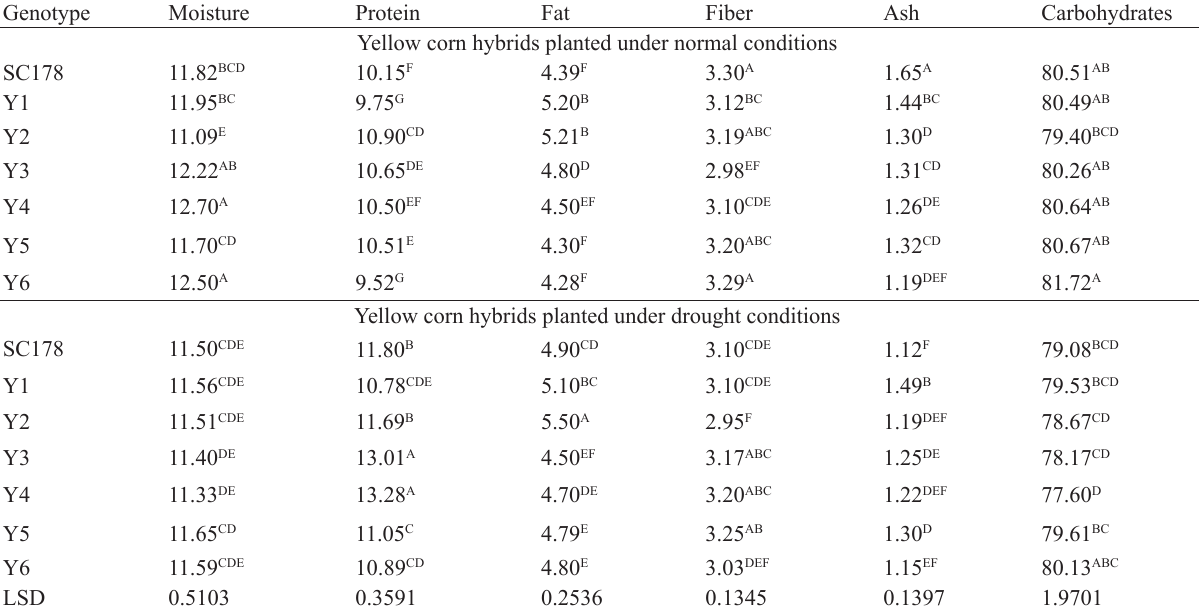
SC178 = Single Cross Giza 178, Y1–Y6 = new yellow corn hybrids Means with the same letters in the same column are not significantly